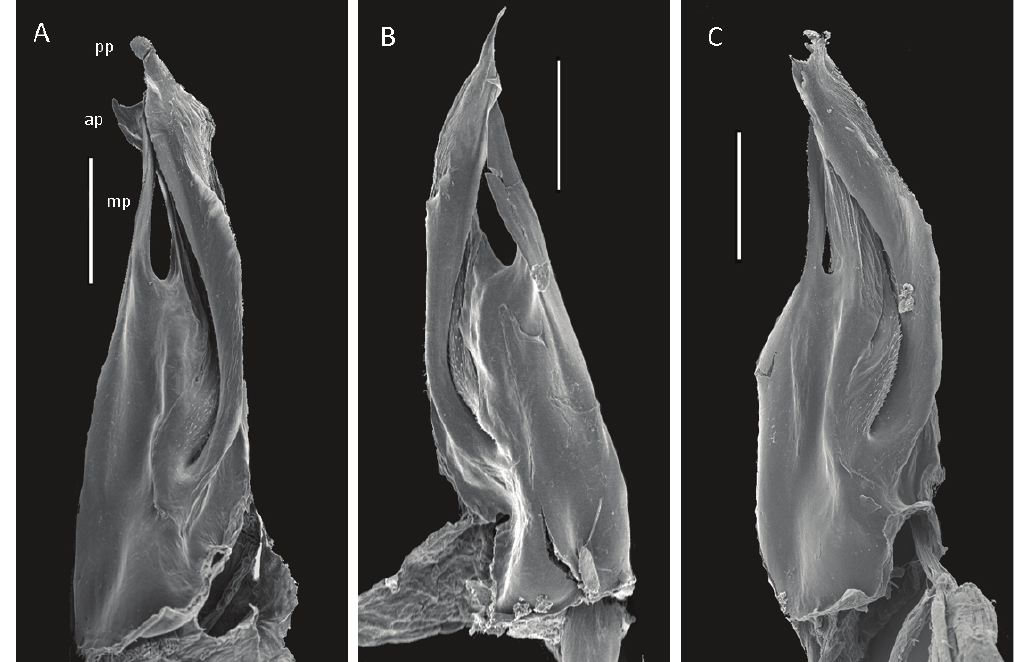
Fig. 4. Posterior gonopods, mesal views. A . D. typhlocanaria sp. nov., specimen from Barranco Draguillo. B . D. typhlocanaria sp. nov., specimen from Cueva de la Luna. C . D. oromii sp. nov. ap: anterior process, pp: posterior process, mp: mesomerital process. Scales 0.1